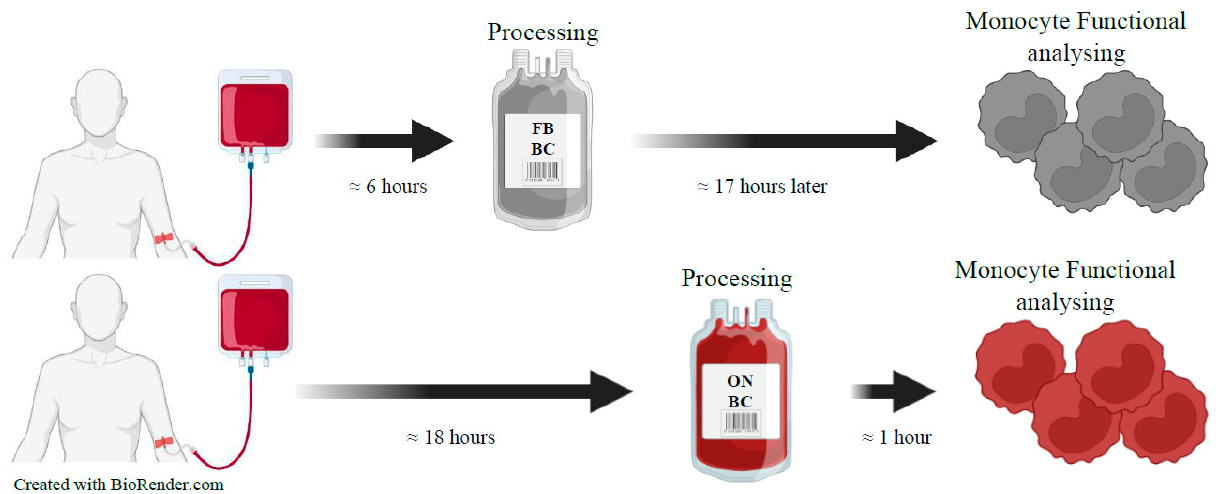
Figure 1. Scheme of the two different timing protocols of processing whole 450 mL blood to obtain BC and respective waiting times. For Fresh Blood BC, the collection and processing of the whole blood occurs on the same day. Fresh Blood BC must wait for the following day to be used in experiments. As for the Overnight Blood BC, the whole blood is only processed one day after the blood collection. The Overnight Blood BC is used for assays on the same day as it is processed. FB BC: Fresh Blood Buffy Coat; ON BC: Overnight Buffy Coat.